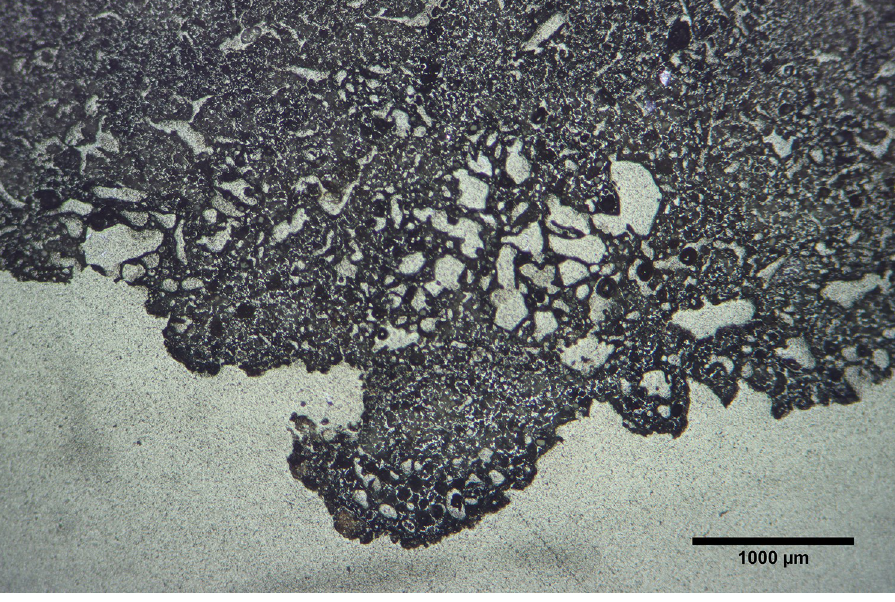
Fig 5. Vitrification of Mayapa´n tuy è res. Photomicrograph of sample M-55 in reflected light demonstrating the bloated microstructure suggesting that the Mayapa´n blowpipe tips are heavily vitrified throughout. Photomicrograph by Jennifer